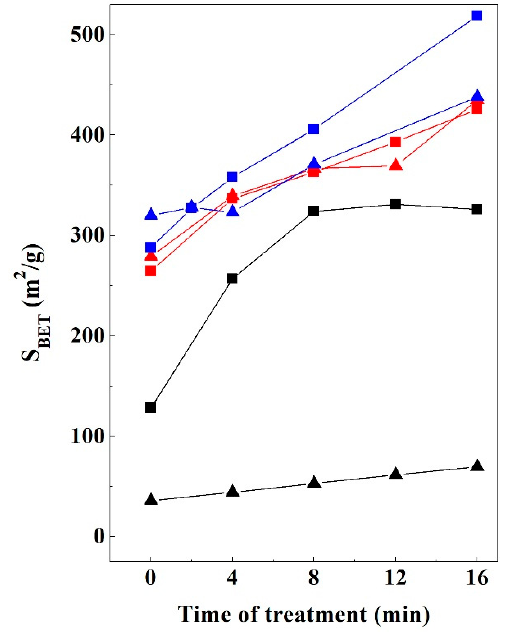
Figure 12. SSA evolution of the 2:1 clay samples studied vs. treatment time: Bm (black triangle), Bs (black square), K1 (red square), K1 (red triangle), Sp1 (blue square), Sp2 (blue triangle). Table 2. Specific surface areas obtained after outgassing at 200 ◦ C or 120 ◦ C of starting 2:1 clay minerals and obtained materials after acid